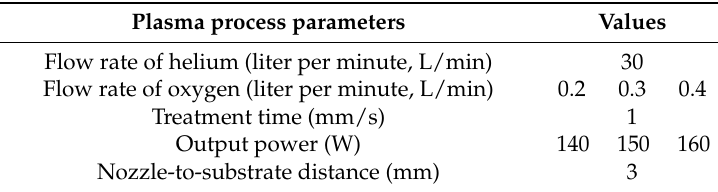
Table 2. Parameters used in plasma